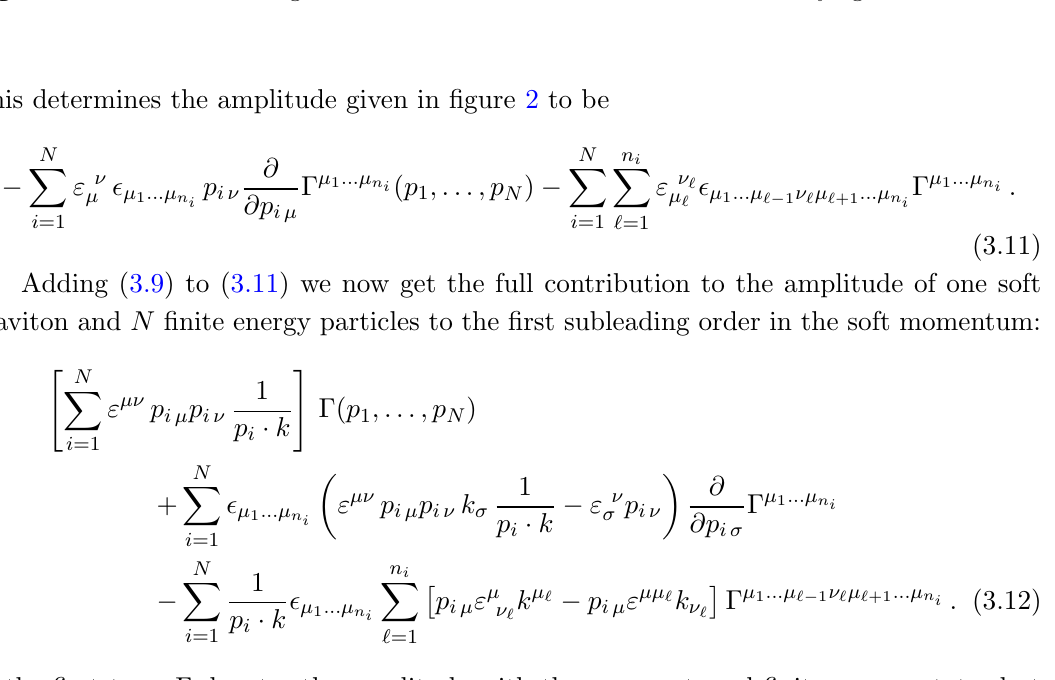
Figure 3 . Two external soft gravitons attached to di(cid:11)erent external lines carrying (cid:12)nite